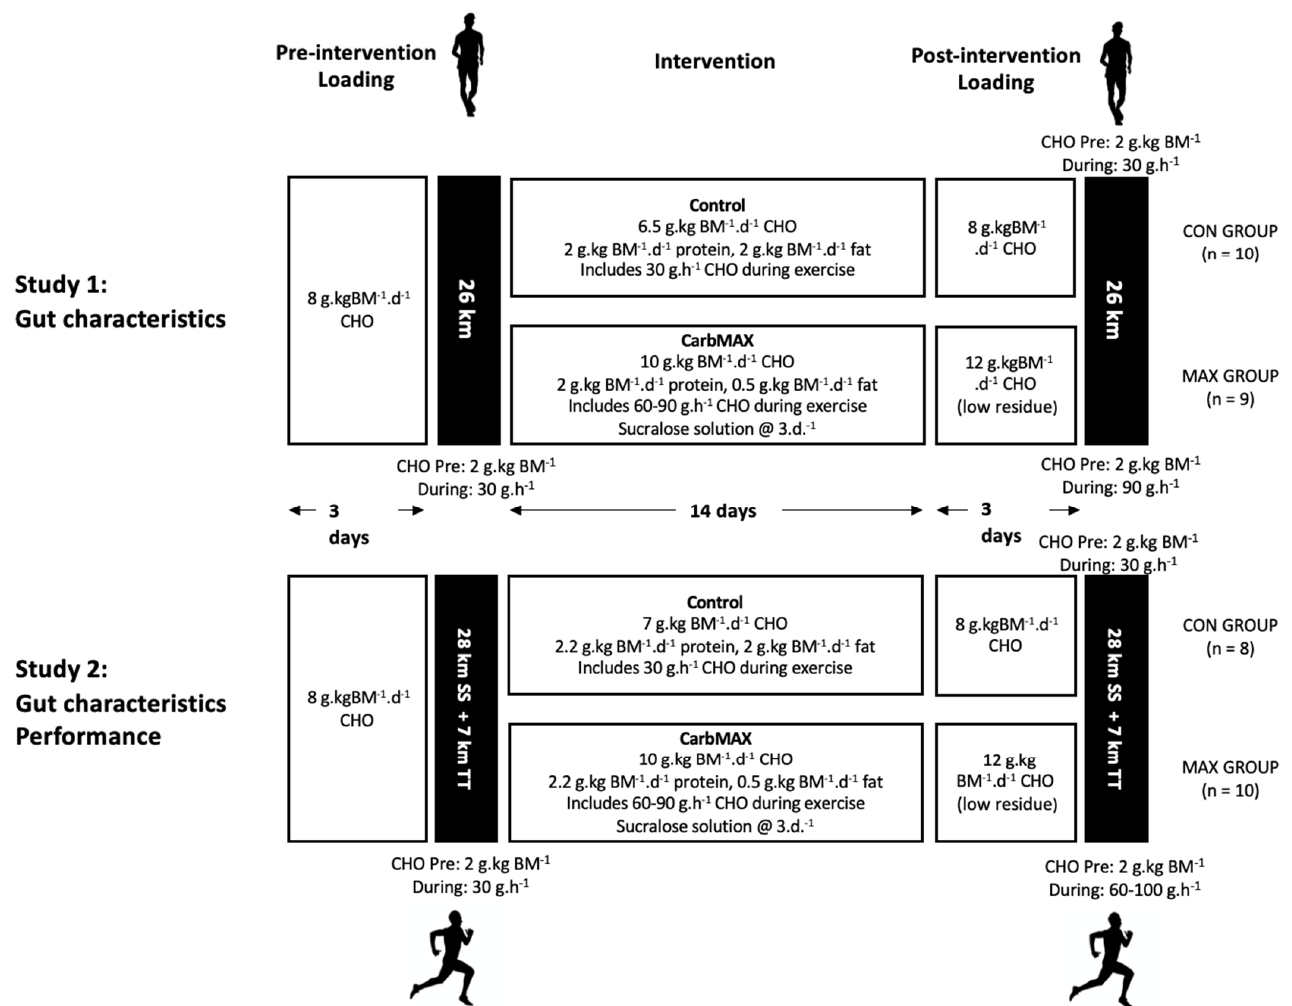
Figure 1. Schematic of the two investigations (race walking: study 1 ) and distance running: ( study 2 ) scheduled within a 4-week training camp involving elite male race walkers ( n = 19) and highly trained marathon runners ( n = 18). BM: body mass; CHO: carbohydrate; CON: control condition; MAX: carb max intervention; SS: steady-state running; TT: time trial; d: day Table 1. Baseline characteristics of participants. Study 1: Race Walkers Study 2: Marathon Runners